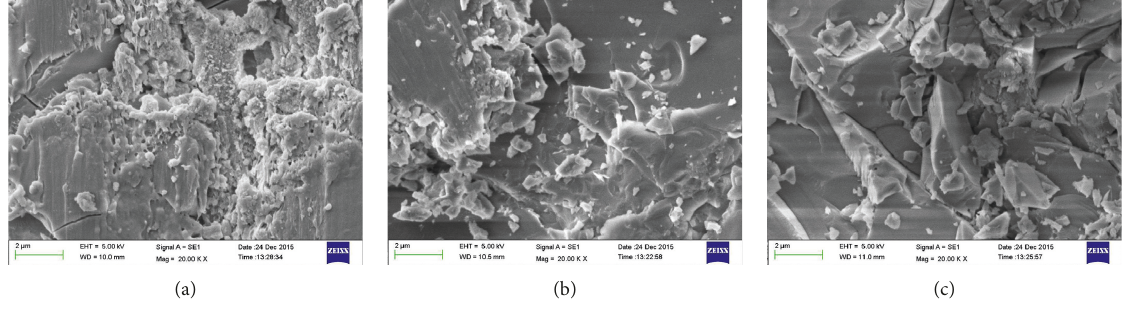
Figure 4: SEM micrographs of UHPC: (a) C2, (b) C3, and (c)